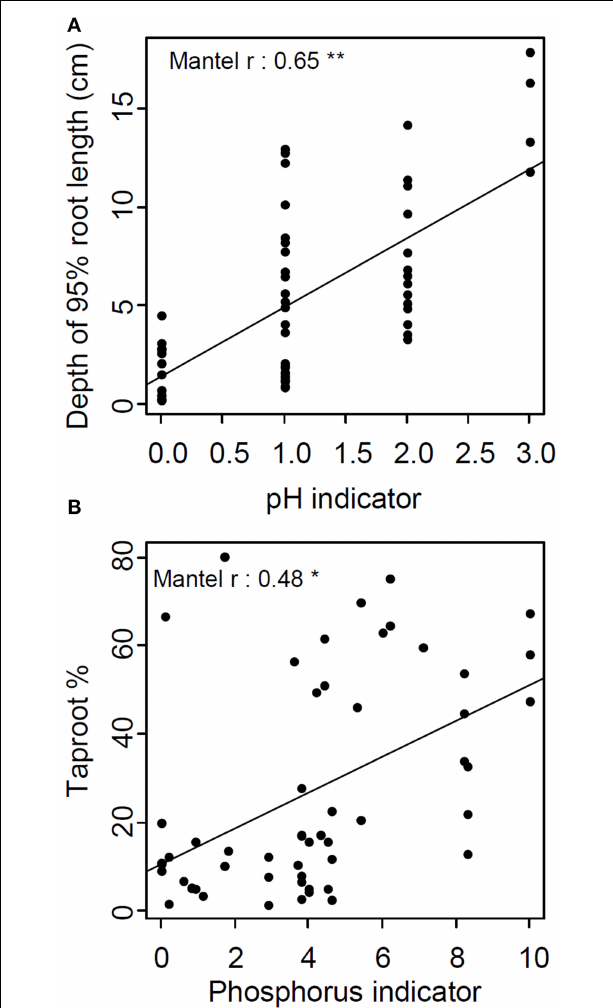
FIGURE 4 | Relation between absolute pair-wise species’ distances of (A) pH indicator and depth of 95% of root length (B) and phosphorus indicator and taproot percentage. Lines represent linear regressions between pair-wise species traits and ecological indicator distances ( ∗ p < 0 . 05, ∗∗ p < 0 .